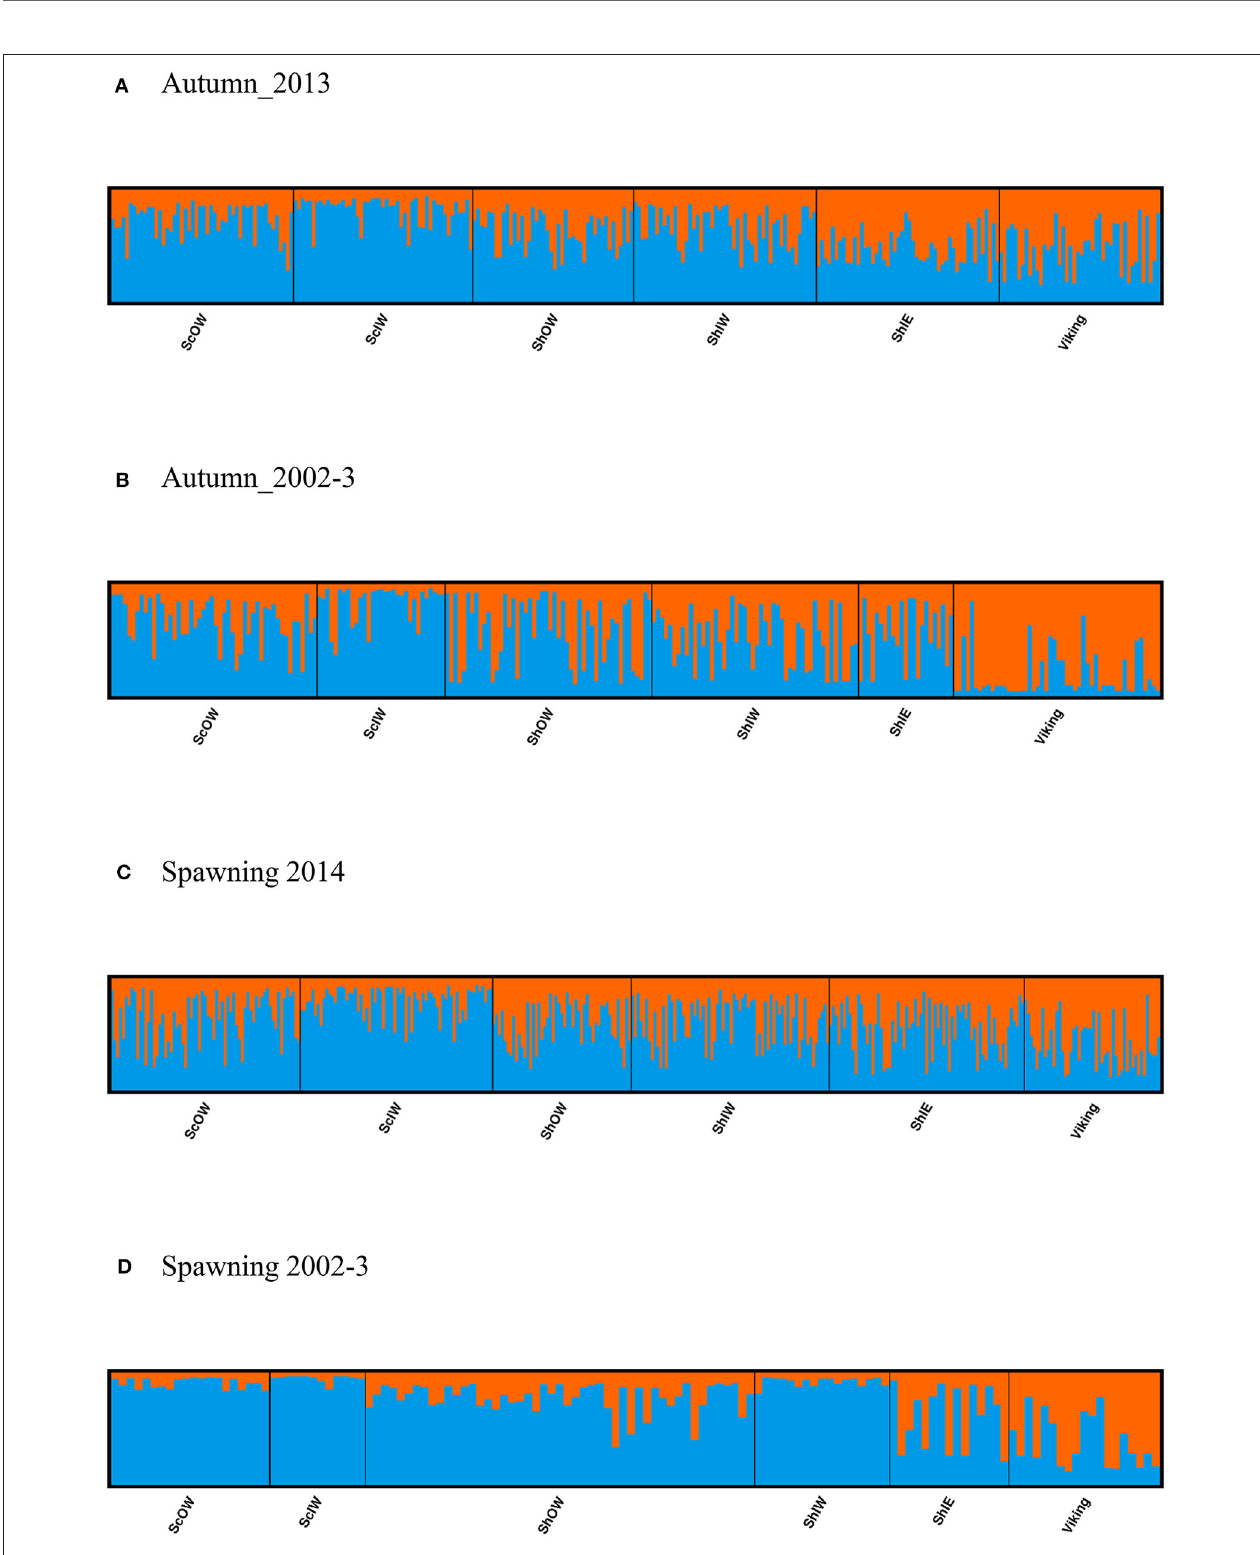
FIGURE 4 | Results from clustering analysis using STRUCTURE with a K value of 2, population groupings are ordered to reflect geographical connectivity with individuals within a given location sorted in ascending longitudinal order for samples captured in (A,B) the Autumn and (C,D) spawning season.